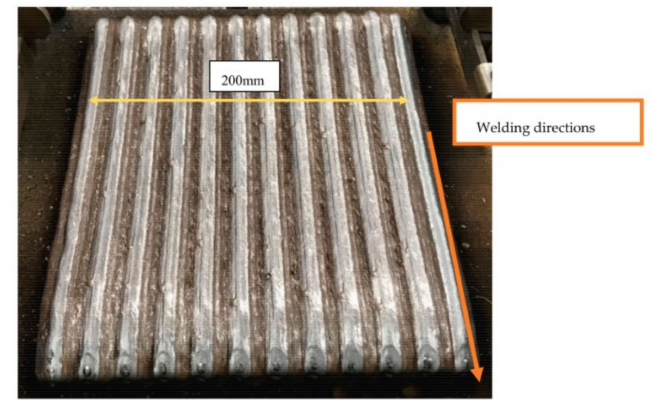
Figure 31. Welded specimen according to